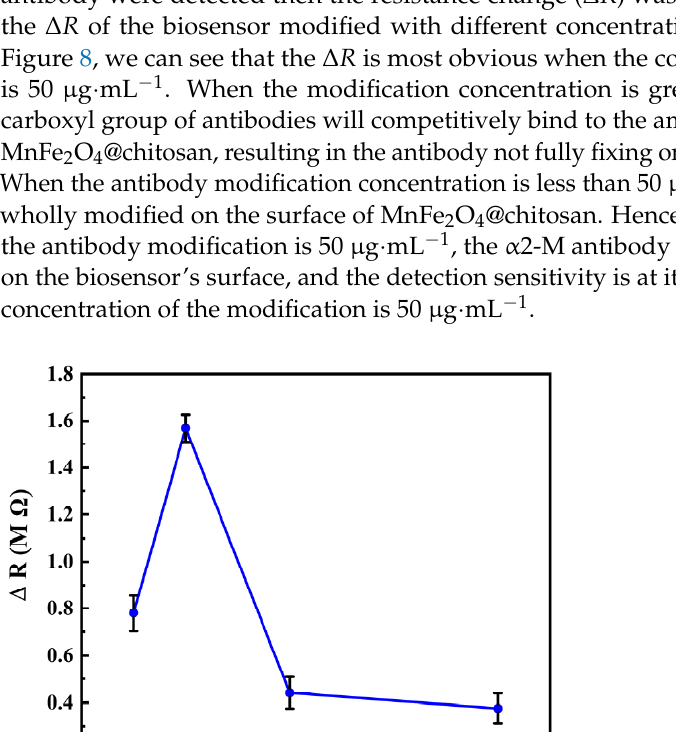
Figure 7. SEM ( a ) and EDS analysis ( d ) and EDS images ( g ) of the MnFe 2 O 4 @chi ‐